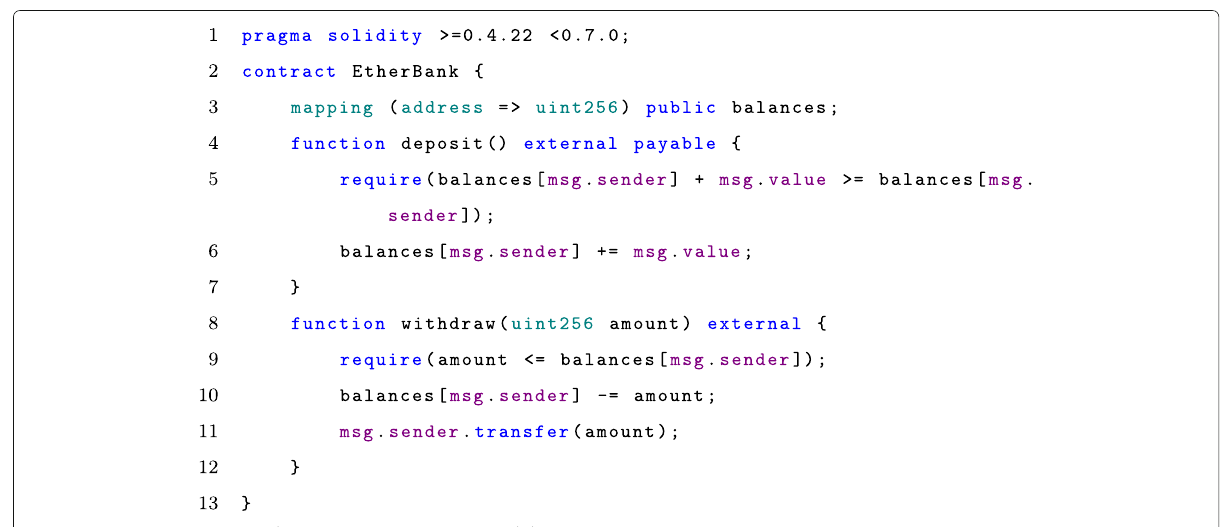
(i.e., tx.gasLimit · tx.gasPrice ) before execution. If, after transaction execution, there are unused gas left, the remaining part will be refunded back to transaction sender in ETH in the same rate as tx.gasPrice